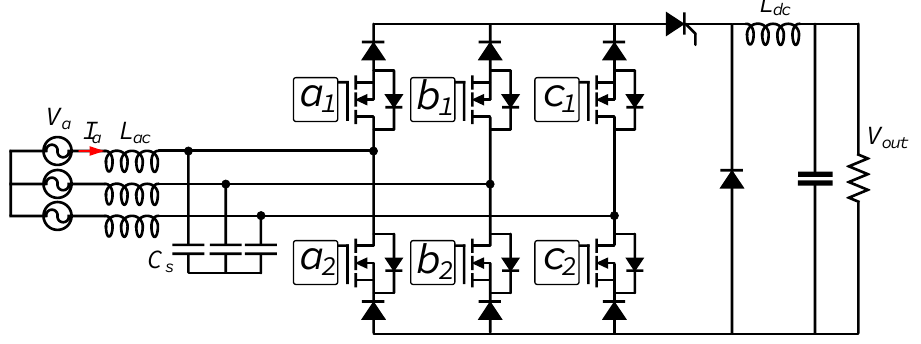
Figure 4. Schematic of the proposed three-phase buck rectifier.